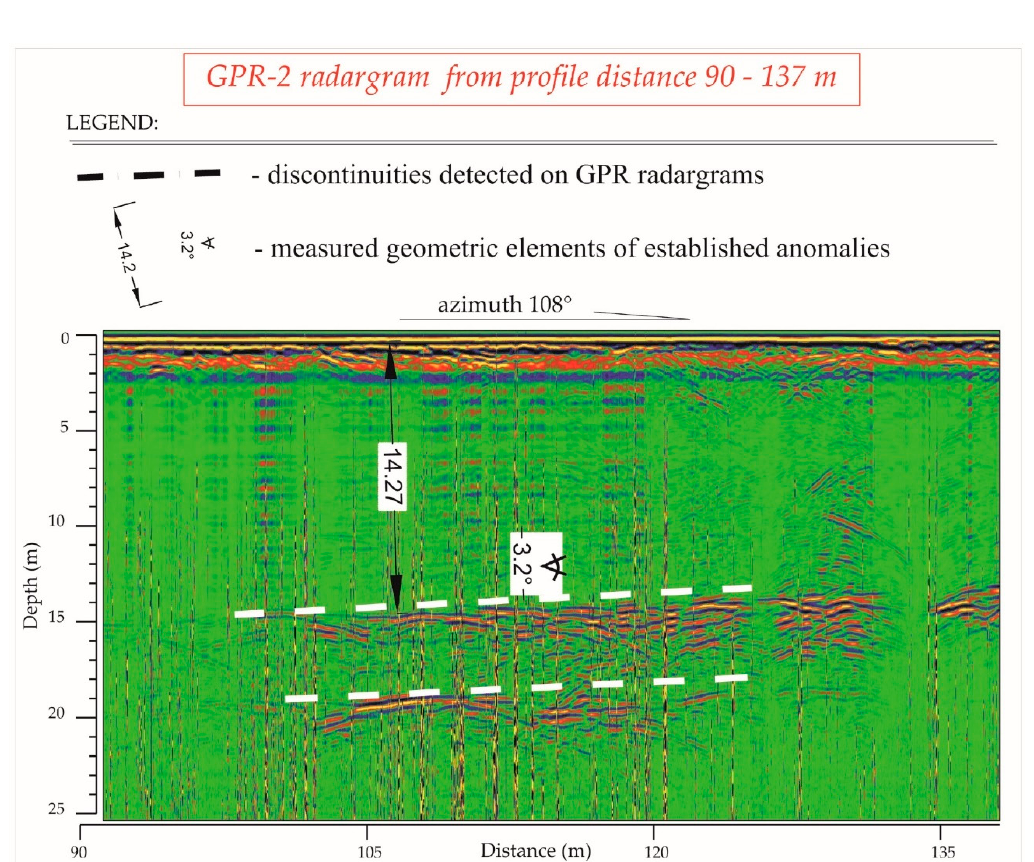
Figure 5. Radargram recorded along line GPR-2 with interpreted stratification planes observed along the profiles. Measured inclination of 3°–5°. Measured dip corresponds well to the observations on surface rock outcrops.